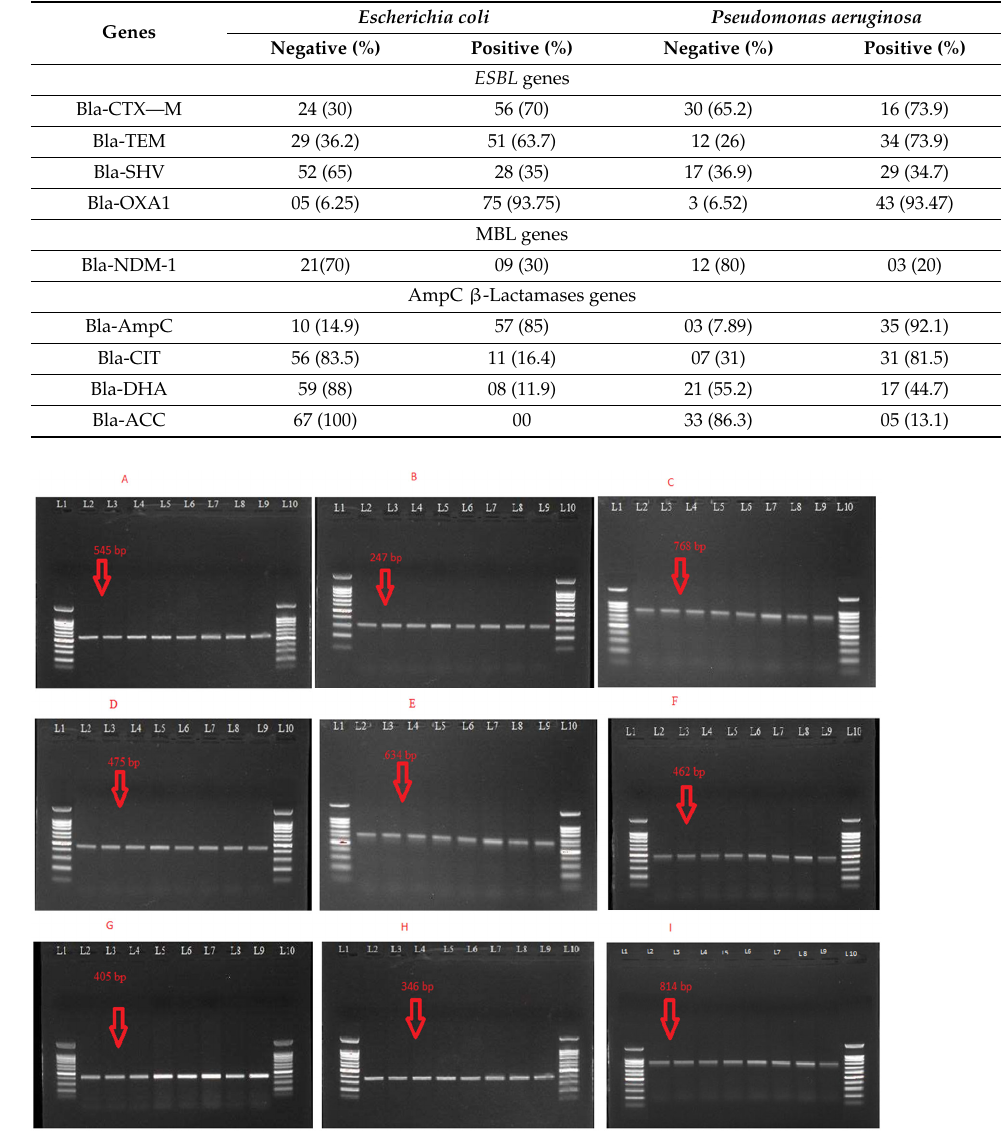
Figure 2. ( A ): Gel image of CTX-M gene (545 bp); L2-9: positive isolates, L1/L10: 100 bp DNA ladder, ( B ): gel image of TEM gene (247 bp); L2-9: positive isolates, L1/L10: 100 bp DNA ladder ( C ): gel image of SHV gene (768 bp); L2-L9: positive isolates, L1/L13: 100 bp DNA ladder, ( D ): gel image of NDM-1 gene (475 bp); L1/L10: 100-bpDNA ladder, L2-9: positive isolates, ( E ): gel image of AmpC gene (634 bp); L1/L10: 100-bp DNA ladder, L2-09: positive isolates ( F ): gel image of CIT gene (462 bp); L1/L10: 100-bp DNA ladder, L2-09: positive isolates, ( G ): gel image of DHA gene (405 bp); L1/L10: 100-bp DNA ladder, L2-09: positive isolates, ( H ): gel image of AAC gene (346 bp); L1/L10: 100-bp DNA ladder, L2-09: positive isolates. ( I ): gel image of OXA-1 gene (814 bp); L1/L10: 100-bp DNA ladder, L2-09: positive